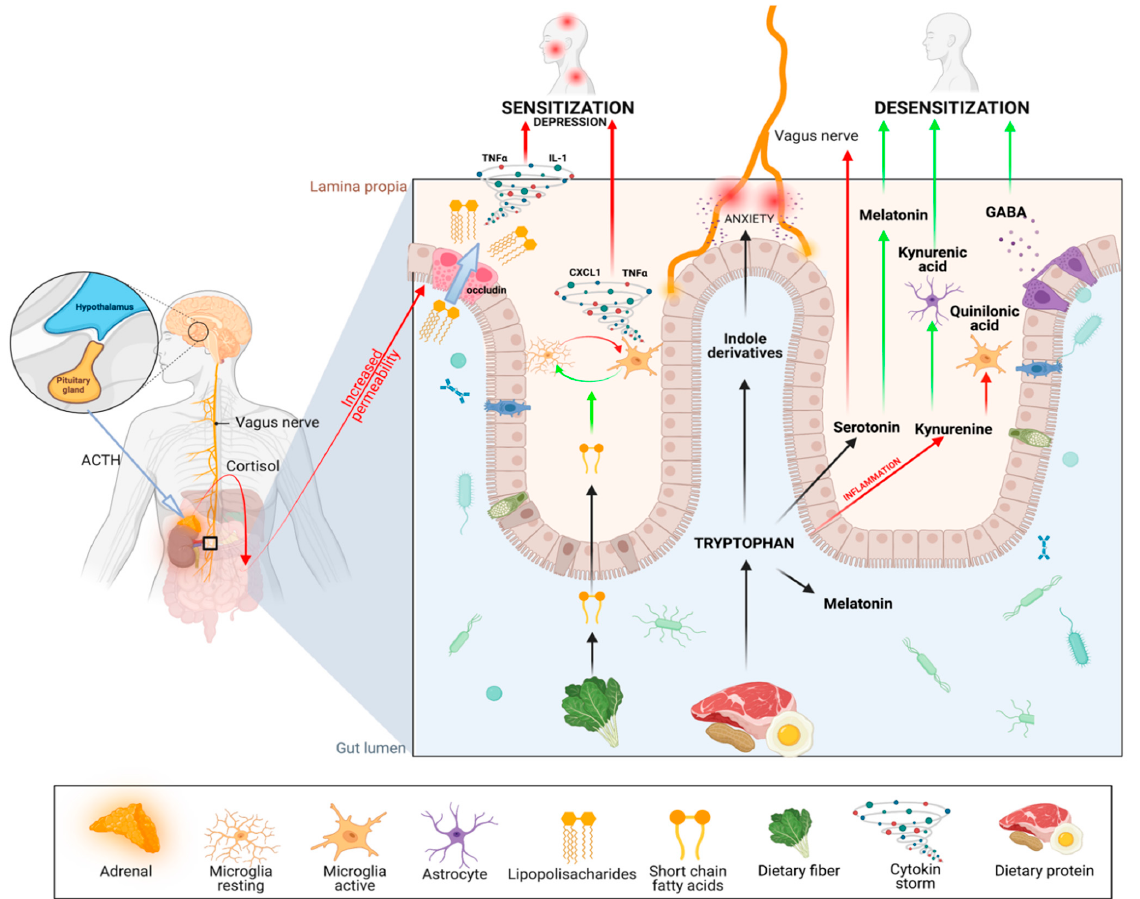
Figure 1. Communication between the gut microbiota and the central nervous system (CNS) in orofacial pain.Within the nervous system, stress can activate the HPA (hypothalamus–pituitary–adrenal) axis response, triggering the release of adrenocorticotrophic hormone (ACTH), which then initiates the synthesis and release of cortisol. Cortisol, in turn, affects intestinal barrier integrity by decreasing occludin levels. Several types of cells in the brain (e.g., microglia, astrocytes) are able to receive signals from the periphery, including the gastrointestinal tract [92–94]. Activation of these cells by lipopolysaccharides contributes to the development of depression and neuritis, which is one of the major mechanisms underlying the central sensitization associated with chronic pain [95,96]. Short-chain fatty acids derived from dietary fiber play an important regulatory role in activating microglia, thus protecting from